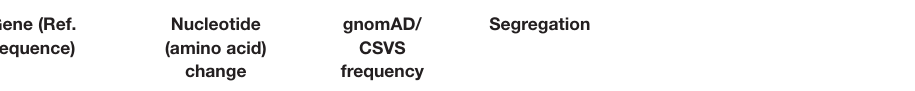
TABLE 2 | In silico analysis of patients’ genetic variants.